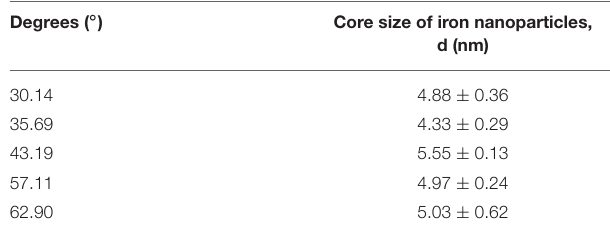
TABLE 1 | The position of peaks (degrees) and the size of γ Fe nanoparticles. Degrees ( ◦